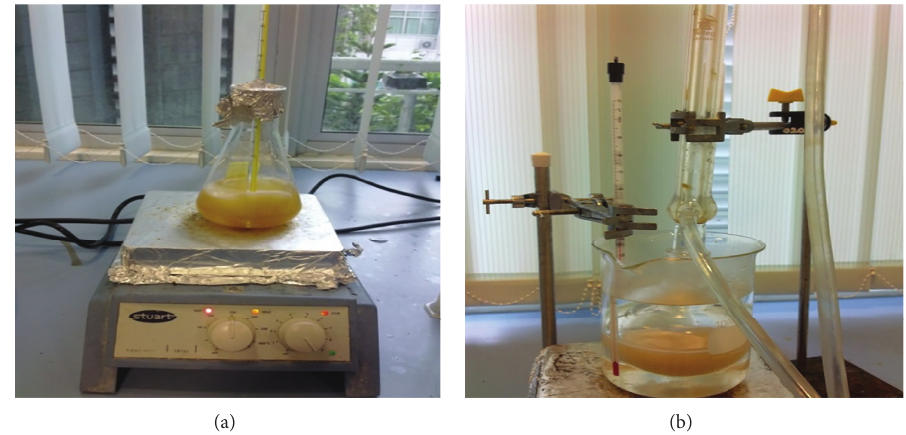
Figure 2: Acid esterification of (a) direct heating and (b) reflux heating.